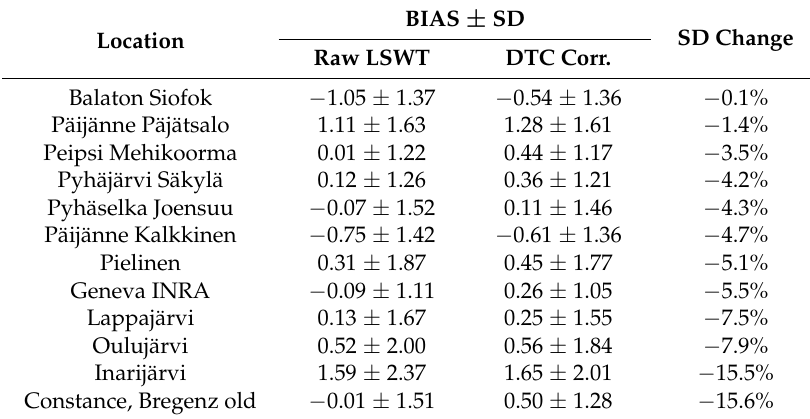
Table 5. Impact of the DTC correction on the validation with daily in-situ data. Whereas for Lake Balaton Siofok, the improvement is neglectable, a considerable performance improvement is observed, for example, at Lake Constance, Bregenz old.